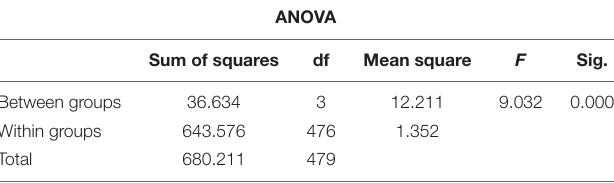
TABLE 3 | One-way ANOVA results for internal learning in teams.